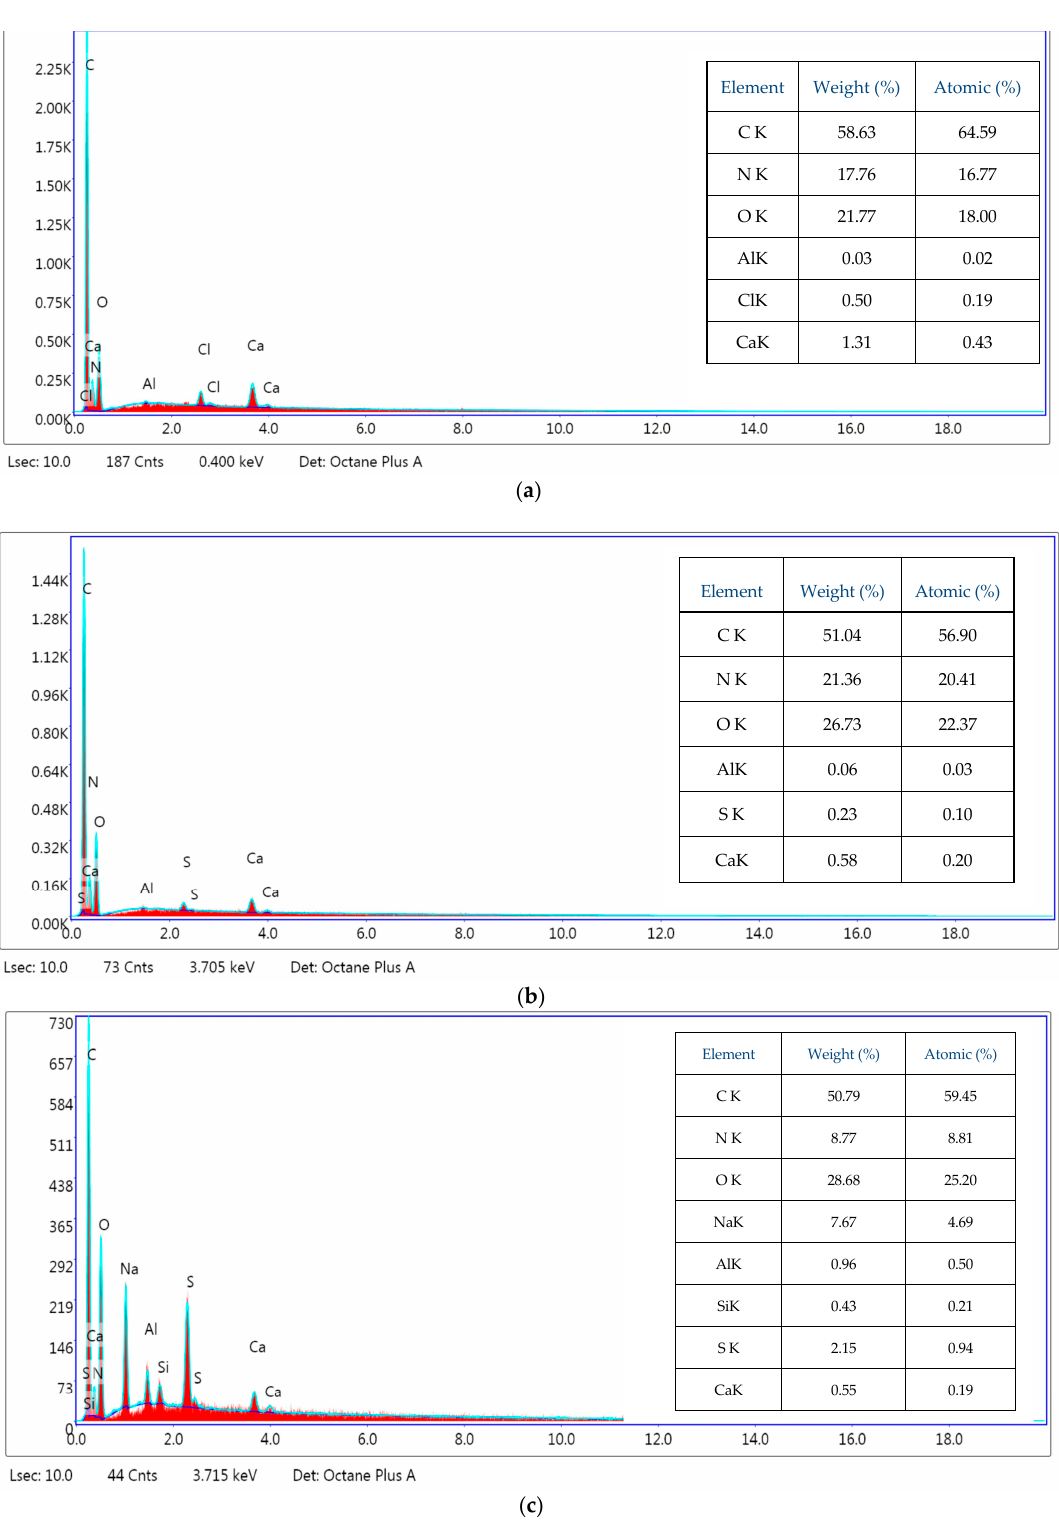
Figure 2. The energy dispersive X-ray patterns of nanofibers: ( a ) HC10CC, ( b ) RCG, and ( c ) KH.